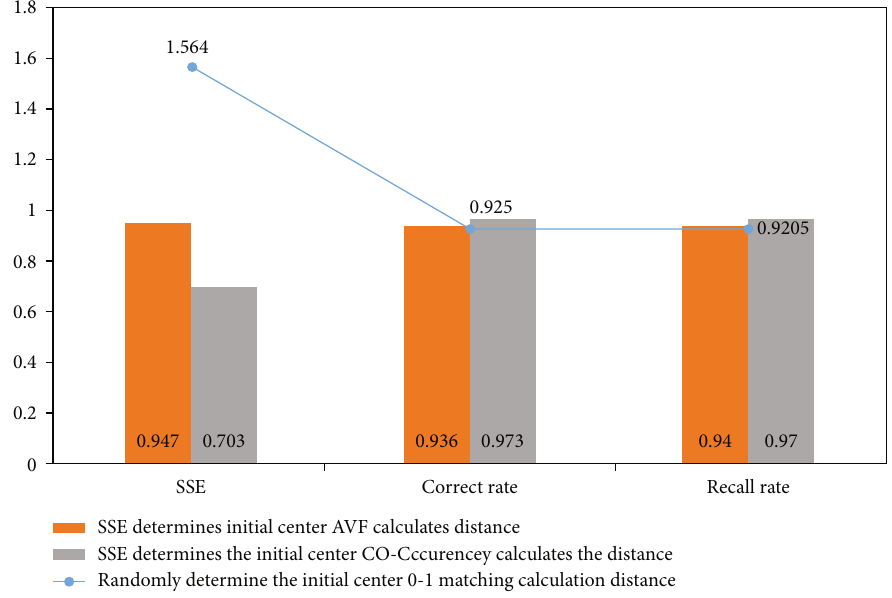
Figure 10: Comparison of three di ff erent clustering algorithms for each index in teaching evaluation